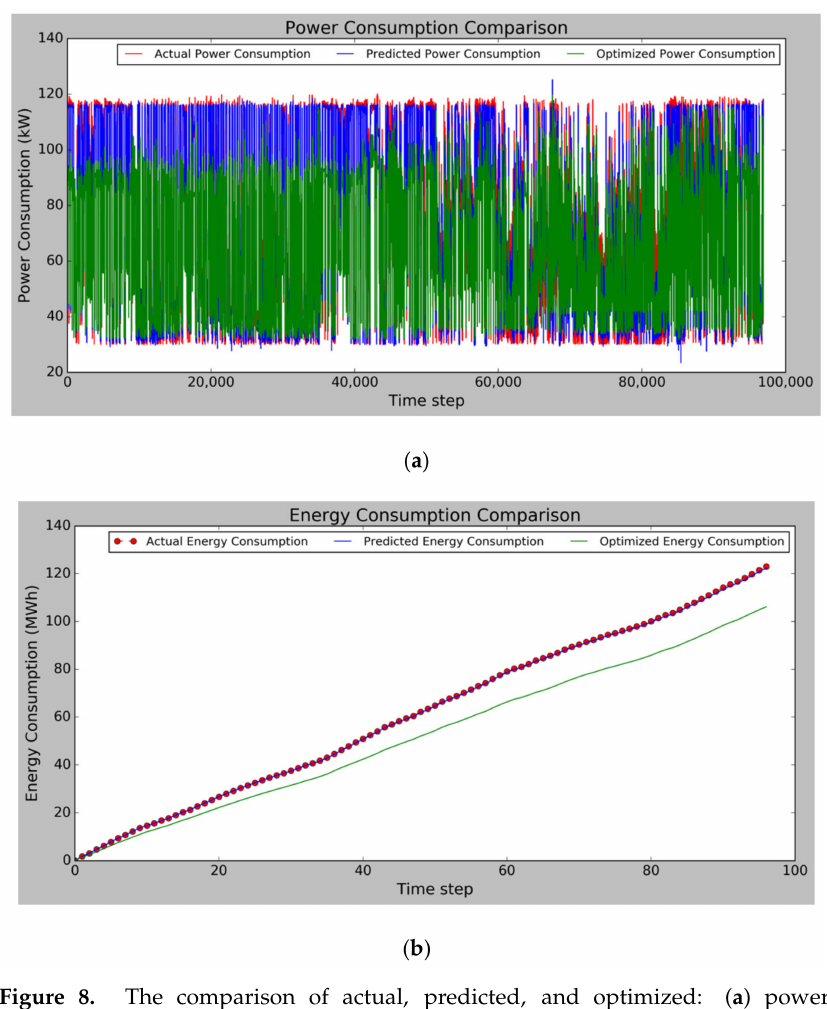
Figure 8. The comparison of actual, predicted, and optimized: ( a ) power consumption, ( b ) energy